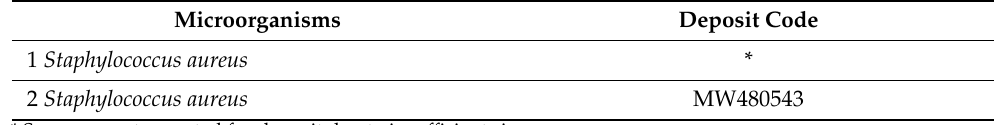
Table 1. Sequence of 16 S rRNA, product of sequencing in this work.